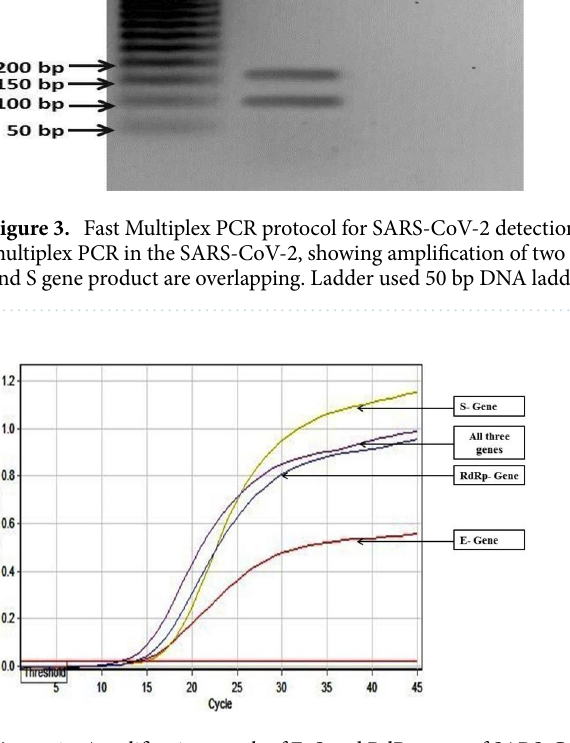
Figure 4. Amplification graph of E, S and RdRp gene of SARS-CoV-2 using SYBR green master mix (TB Green Premix Ex Taq II, Takara, Cat. No: RR820B). All the three primers were tested individually as well as in multiplexing reaction in single tube. Amplification plot showed efficient amplification of the three gene individually and also upon multiplexing of the three primers.